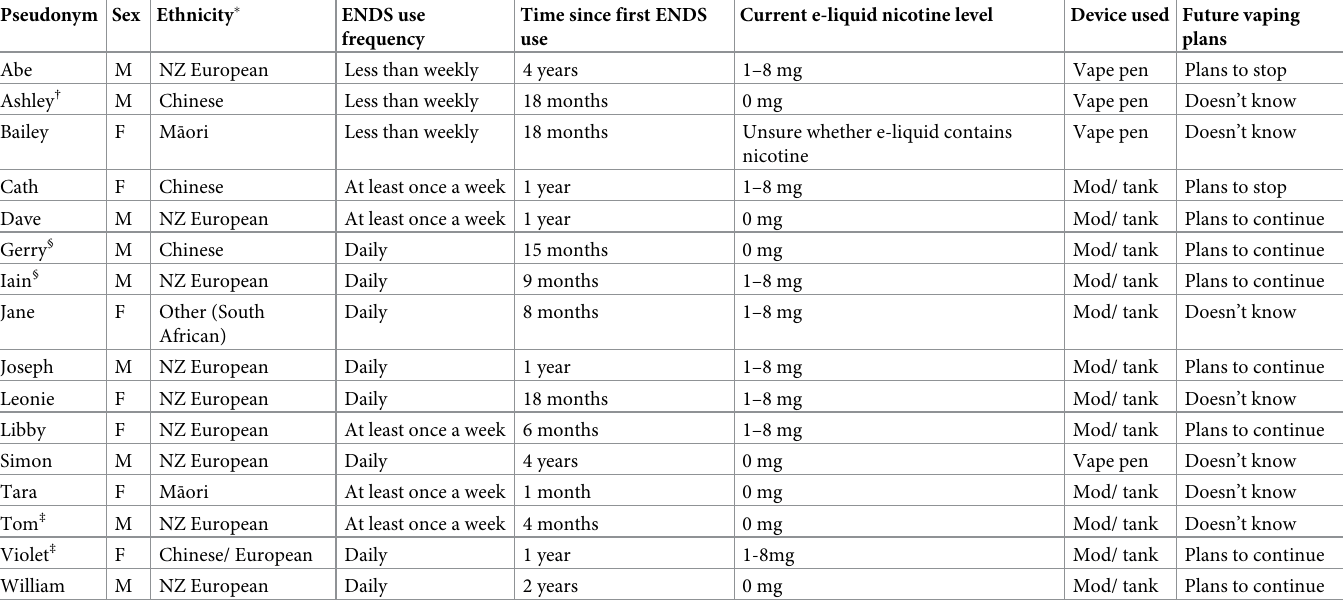
Table 1. Participant